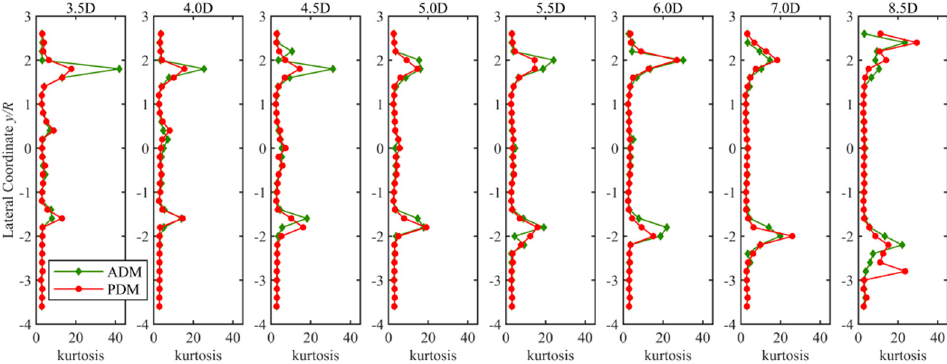
Figure 22. Kurtosis downstream in the ADM and PDM measured at hub height (UIF conditions).